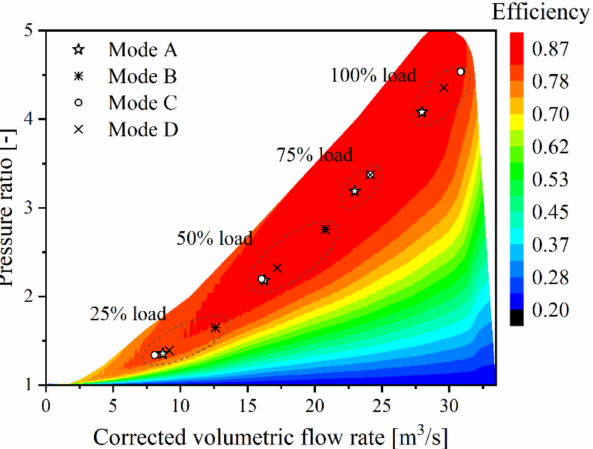
Figure 13. TC-L compressor operating points for the four studied engine operating